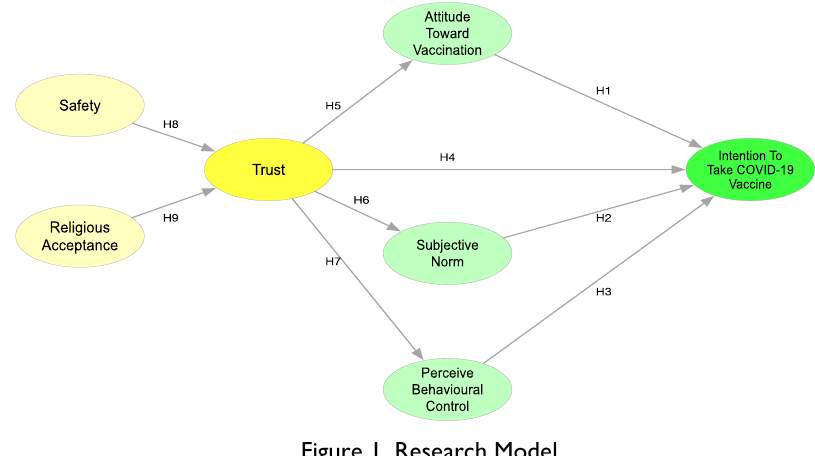
Figure 1. Research